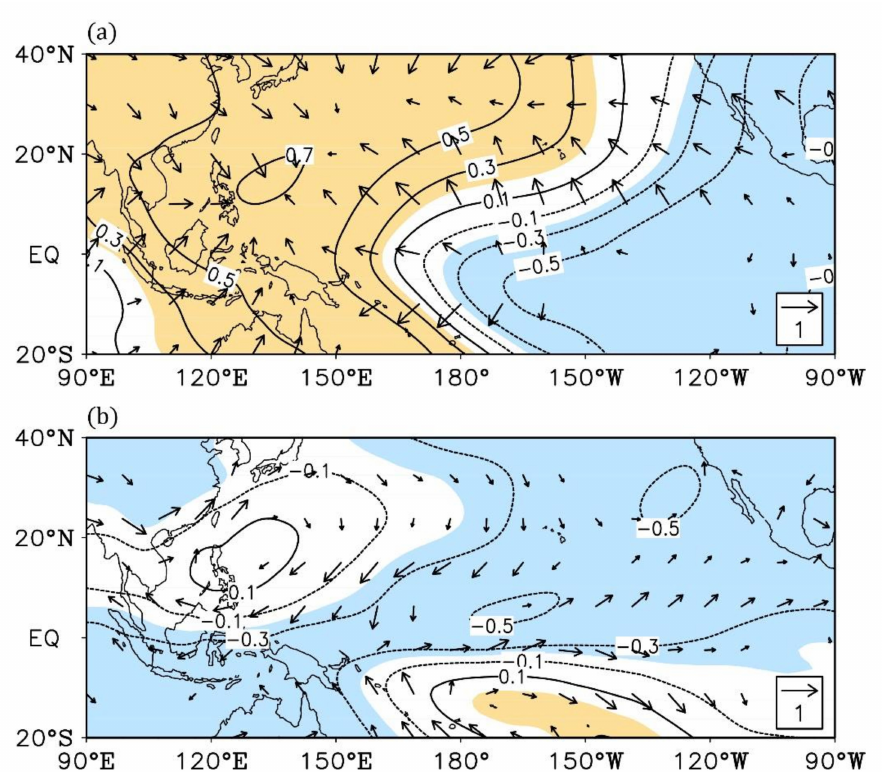
Figure 2. ( a ) Correlation coefficients of velocity potential (contours; the colored areas are significant with p < 0.1) and divergent wind (arrows; only arrows significant with p < 0.1 are shown) anomalies in spring at 200 hPa with the preceding winter Oceanic Niño Index (ONI) during 1958–2019. ( b ) Same as in ( a ), but for the spring stream function (contours; the colored areas are significant with p < 0.1) and rotational wind (arrows; only arrows significant with p < 0.1 are shown) anomalies at 850